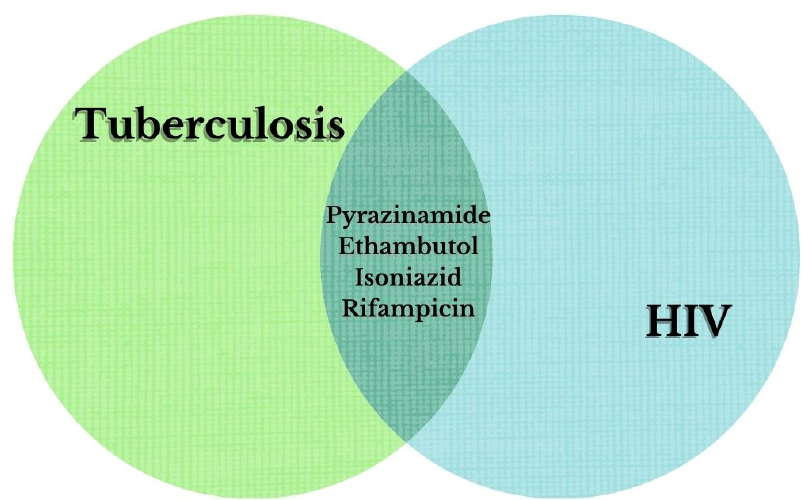
Figure 5. A Venn diagram summarization to depict the inter-relationships between the TB and HIV treatments.